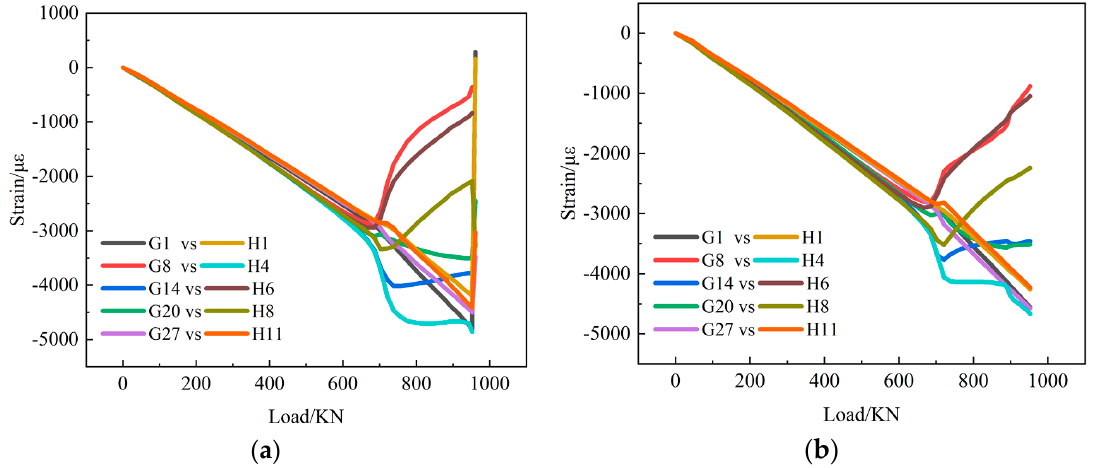
Figure 8. Back-to-back strain measuring points on the skin. ( a ) C1-Static-1; ( b ) C1-Fatigue-1.